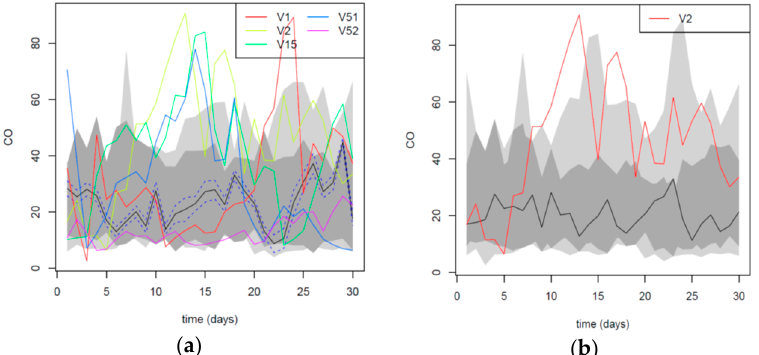
Figure 1. ( a ) Functional bagplot analysis of the CO curve; ( b ) HDR boxplot analysis of the CO curve.